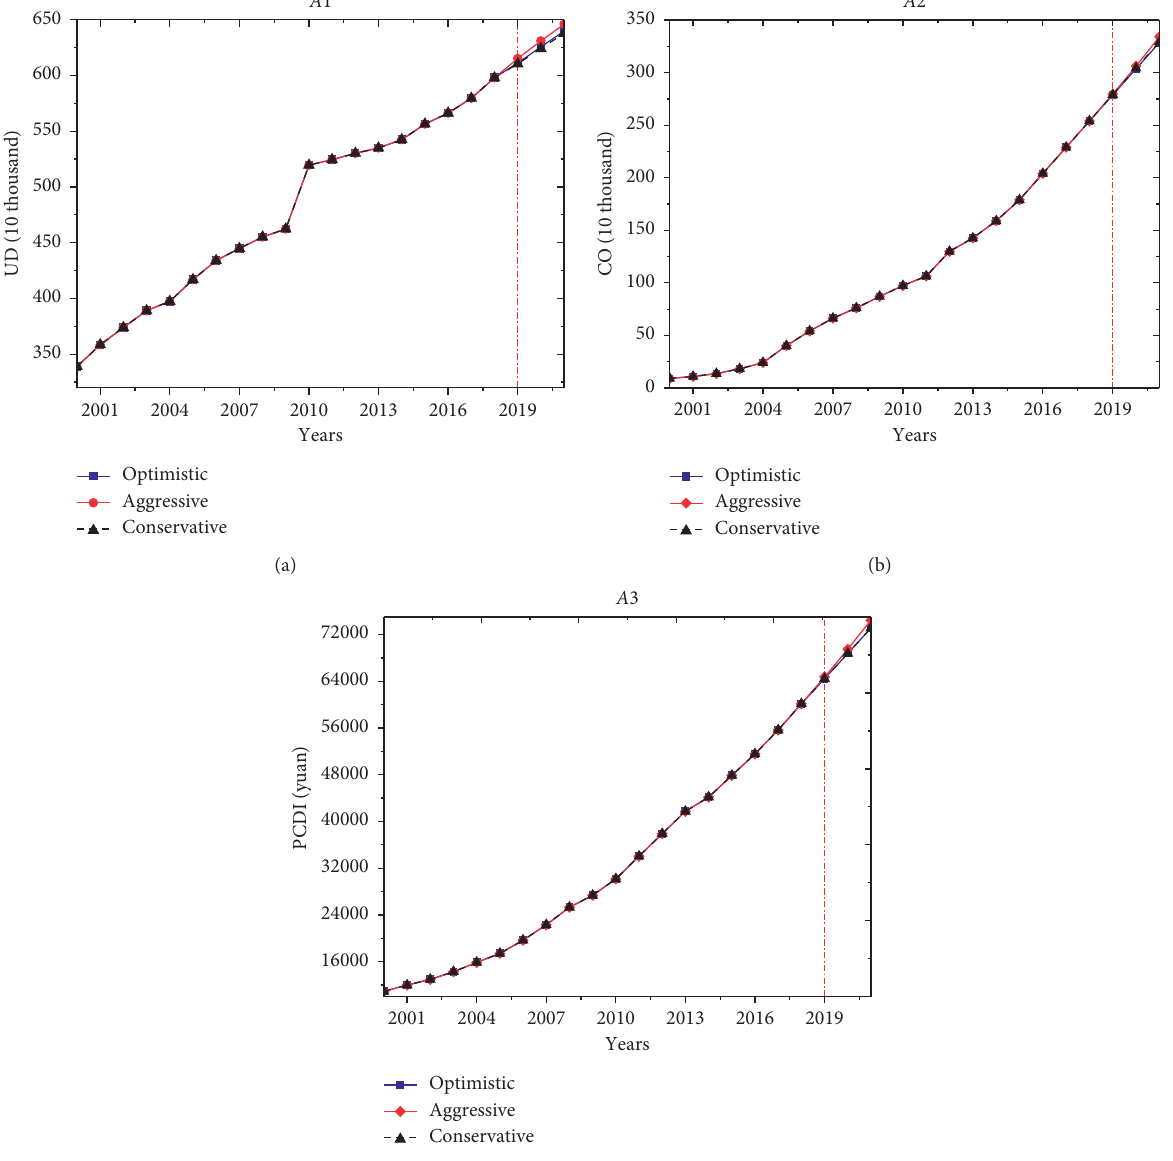
Figure 7: Future changes in the three data series for Ningbo (2019–2021): (a) future changes in UD, (b) future changes in CO, and (c) future changes in